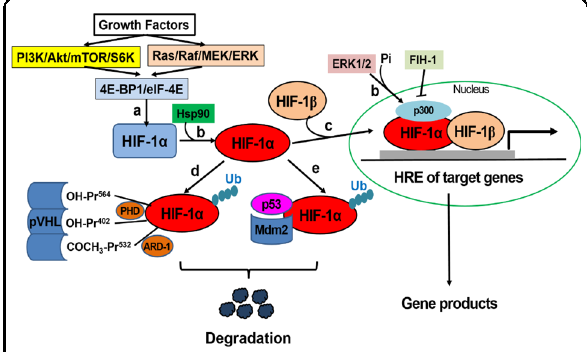
Fig. 1 Regulation of the HIF-1 α pathway. a Growth factor-induced HIF-1 α protein synthesis pathways. b HIF-1 α transactivation through an interaction with Hsp90 or p300 that is phosphorylated by ERK1/2. c Heterodimerization of HIF-1 α and HIF-1 β . d VHL-related degradation pathways. e Mdm2/p53-mediated ubiquitination and proteasomal degradation